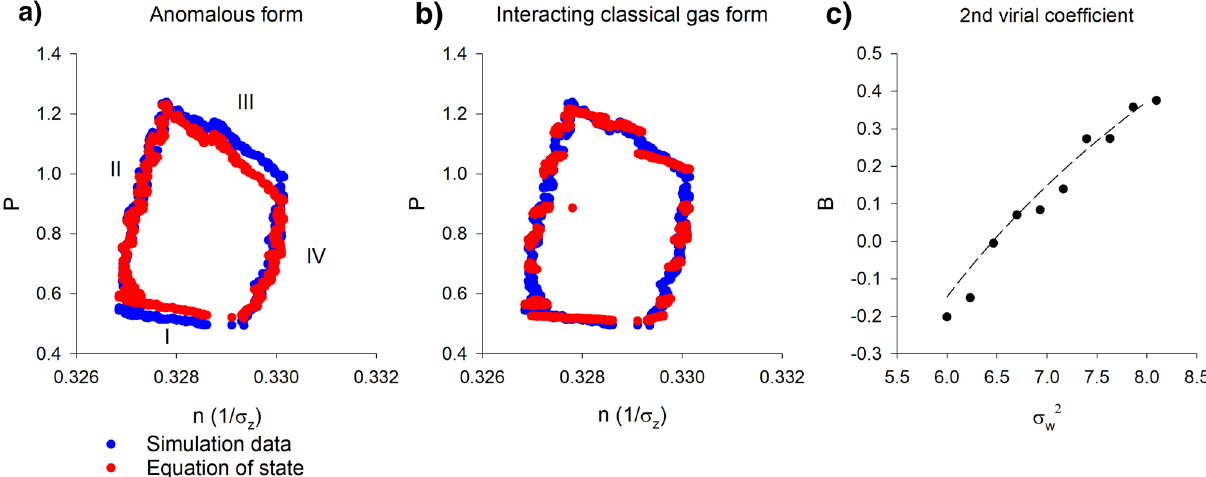
Figure 9. Simulated and predicted thermodynamic cycling. Simulation data were obtained using the simple stochastic model, Eq. (4), for the bipartite swarm shown in Fig. 7a. Cycling the strengths of noises (strong multiplicative noise, weak additive noise; strong multiplicative noise, strong additive noise; weak multiplicative noise, strong additive noise; weak multiplicative noise, weak additive noise) drives the simulated swarm through a ‘thermodynamic’ cycle that resembles observations 8 . ( a ) Predictions were obtained using the equation of state, Eq. (5), with c 1 = 0.001, c 2 = 1.59, c 3 = 2.69 and ( b ) with the virial-like expansion. ( c ) The second-order virial coefficient was obtained from fits to the simulation data. The second-order virial coefficient is well represented b a by B (dashed-line) which corresponds to a van der Waals gas. Each phase has duration 0.25 (a.u.) and σ 2 w = − F 1 = 1 throughout. Phase I F 2 = 2, F 3 = 1; Phase II F 2 = 2, F 3 = 2; Phase III F 2 = 0, F 3 = 2; Phase IV F 2 = 0, F 3 =